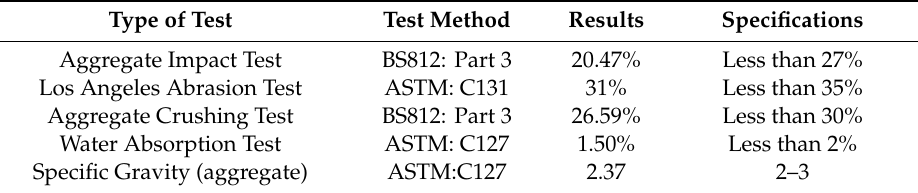
Table 2. Standards of Testing Aggregate